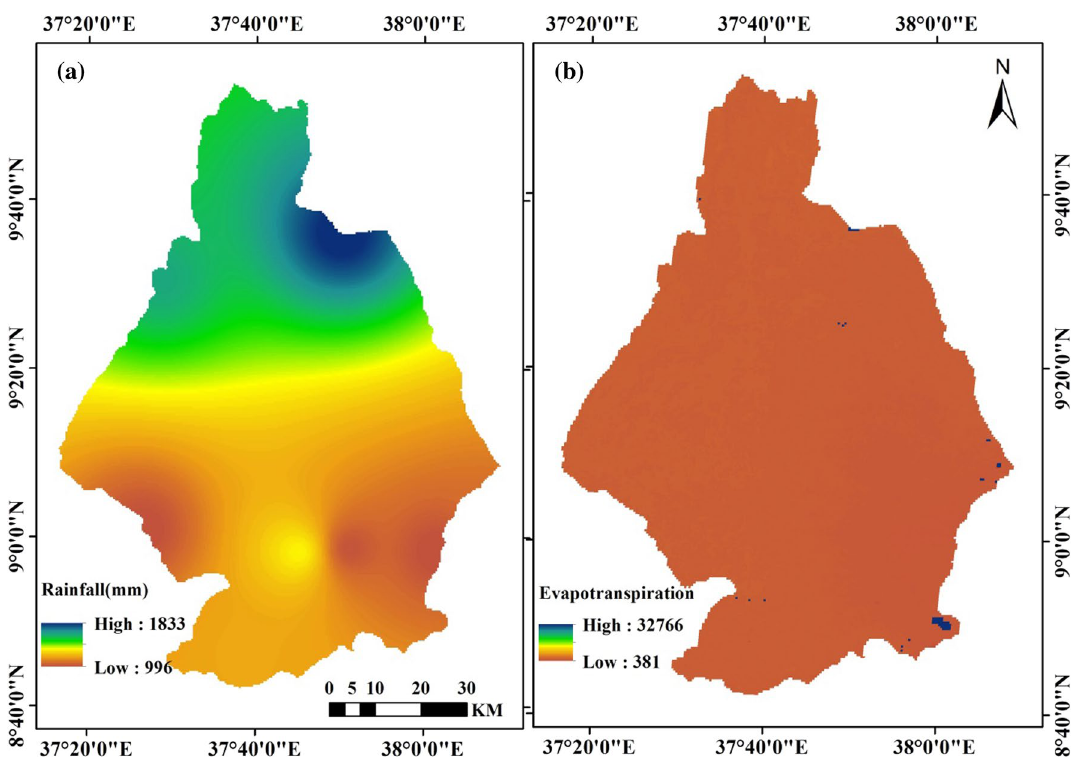
Fig. 5 a Long-term annual average rainfall (mm) for the period 1987 to 2017, b long-term average potential evapotranspiration (mm) for the period 2000 to